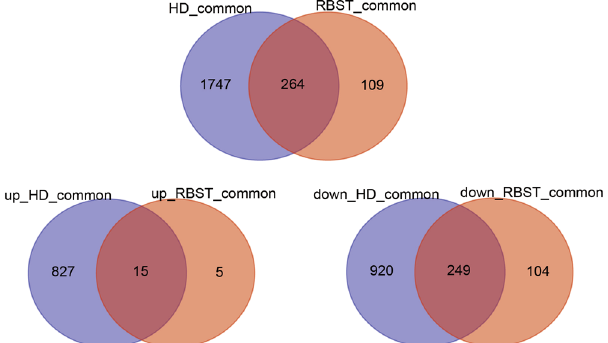
Figure 3. Venn diagram showing the commonalities and differences in two lists of shared differentially expressed genes. Shared differentially expressed genes are those differentially expressed at both 12 h and 72 h in HD or